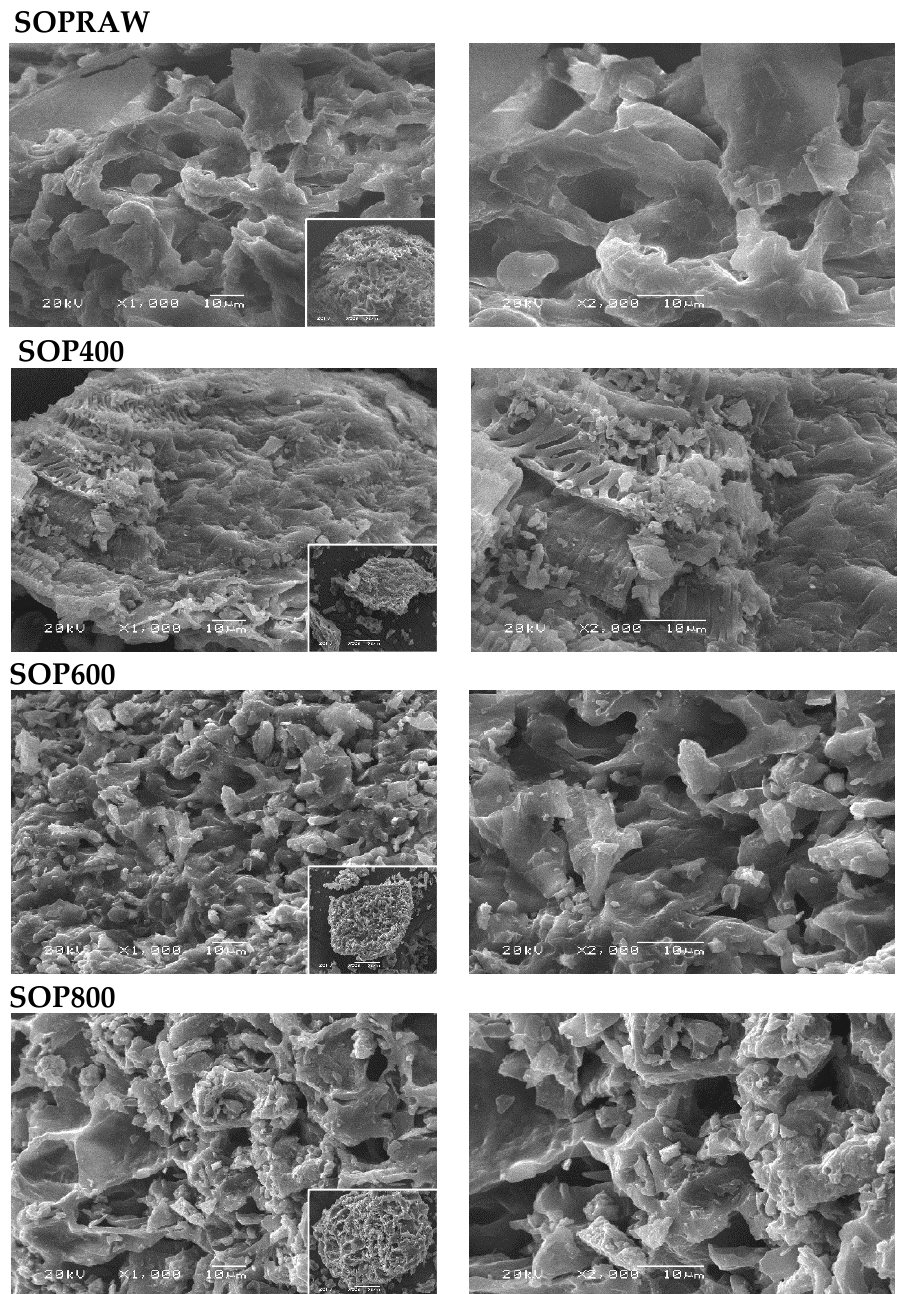
Figure 1. SEM images of SOPRAW, SOP400, SOP600, and SOP800.